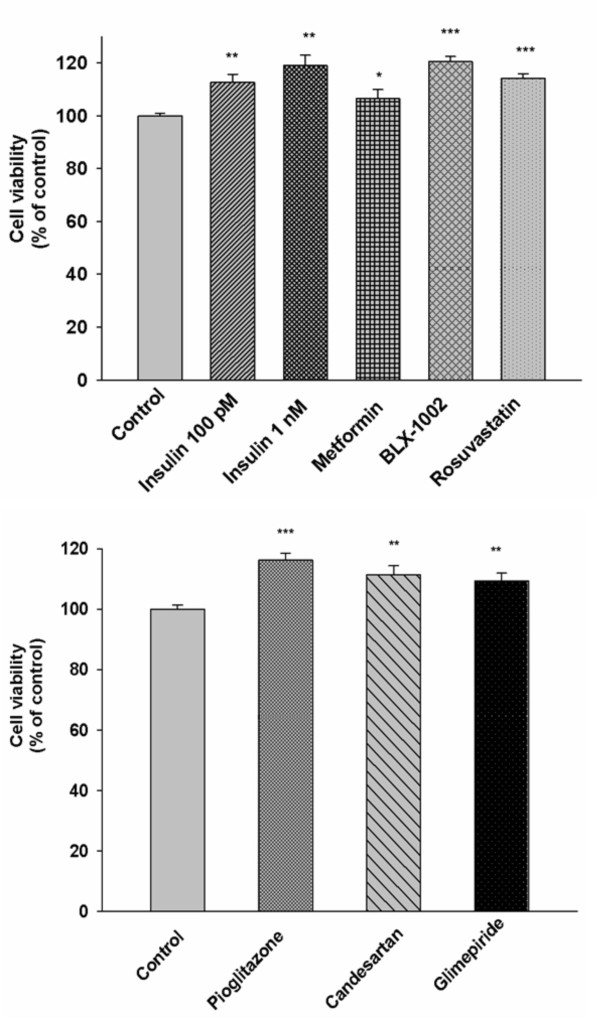
Insulin, metformin, BLX-1002, rosuvastatin, pioglitazone, candesartan and glimepiride increase HCAEC viability. Cells were incubated for 48 h in medium supplemented with 0.5% FBS in the presence or absence of insulin lispro (100 pM and 1 nM), metformin (500 μM), BLX-1002 (1 μM), rosuvastatin (10 nM), pioglitazone (2.5 μM), candesartan (100 nM) and glimepiride (1 μM). Viability was assessed with Trypan blue exclusion. * denotes P < 0.05, ** denotes P < 0.01, *** denotes P < 0.001 for chance differences compared to controls by Student's t-test.